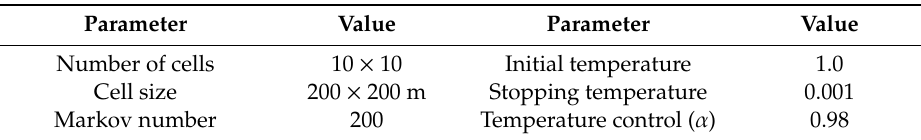
Table 2. Parameters of the Layout